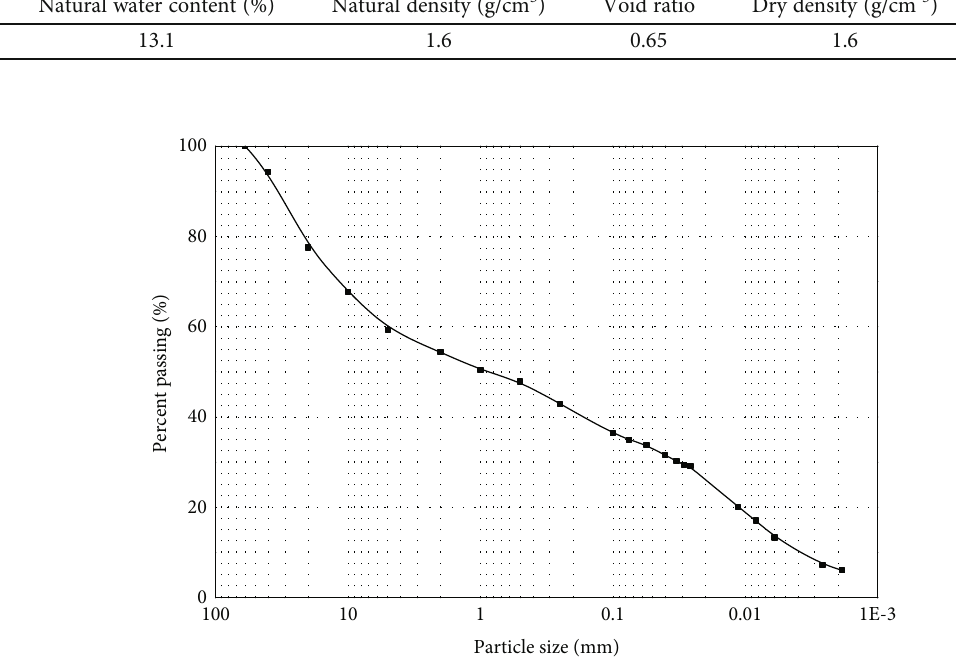
Figure 4: Grain-size distribution curve of soil samples.